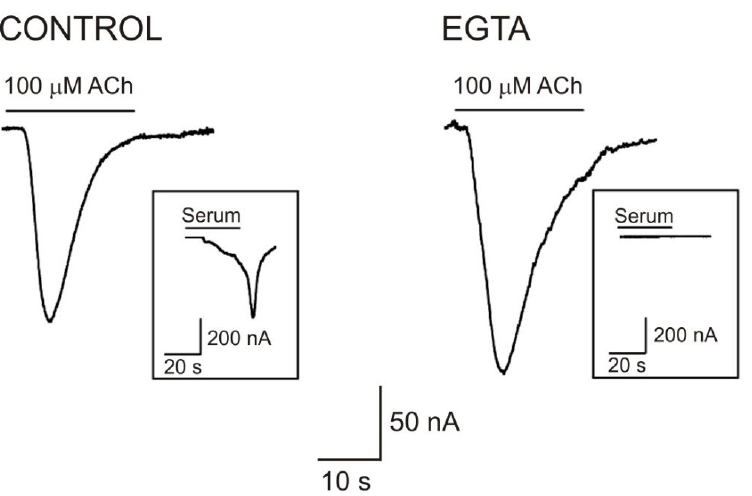
Figure 3. The microtransplantation of proteoliposomes to the Xenopus oocyte membrane does not depend on the increase in the intracellular calcium concentration ([Ca 2+ ] i ). ACh-elicited currents in oocytes microinjected with proteolipomes bearing nAChRs in the control oocytes ( left , control) and in oocytes previously loaded with ca. 5 nM EGTA to chelate [Ca 2+ ] i ( right ). Note the slower desensitization on nAChRs in the EGTA loaded